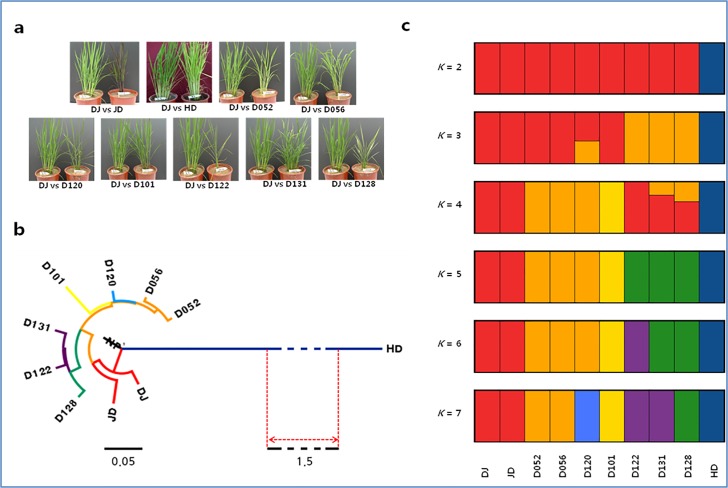
Population structure of 10 rice leaf-color accessions.(a) Comparison of the phenotypes of nine leaf-color accessions with that of the Dongjin cultivar (wild type). (b) A neighbor-joining phylogenetic tree of the rice genomes based on 3,880,945 high-quality SNPs, which were identified in all 10 of the rice accessions. The phylogenetic tree was generated with 1,000 bootstrap repetitions, and all nodes were clustered with bootstrap values (greater than 95%) except for the Hwangdo-cultivar node. (c) A population-structure analysis using FRAPPE with high-quality SNPs. Each accession is represented by a vertical bar.